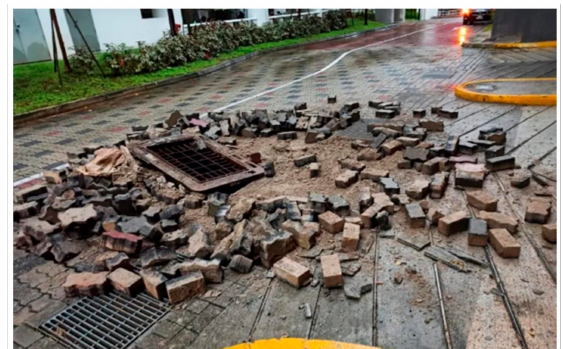
Figure 2. Pothole due to lightning strikes in Batok Town, Bukit,